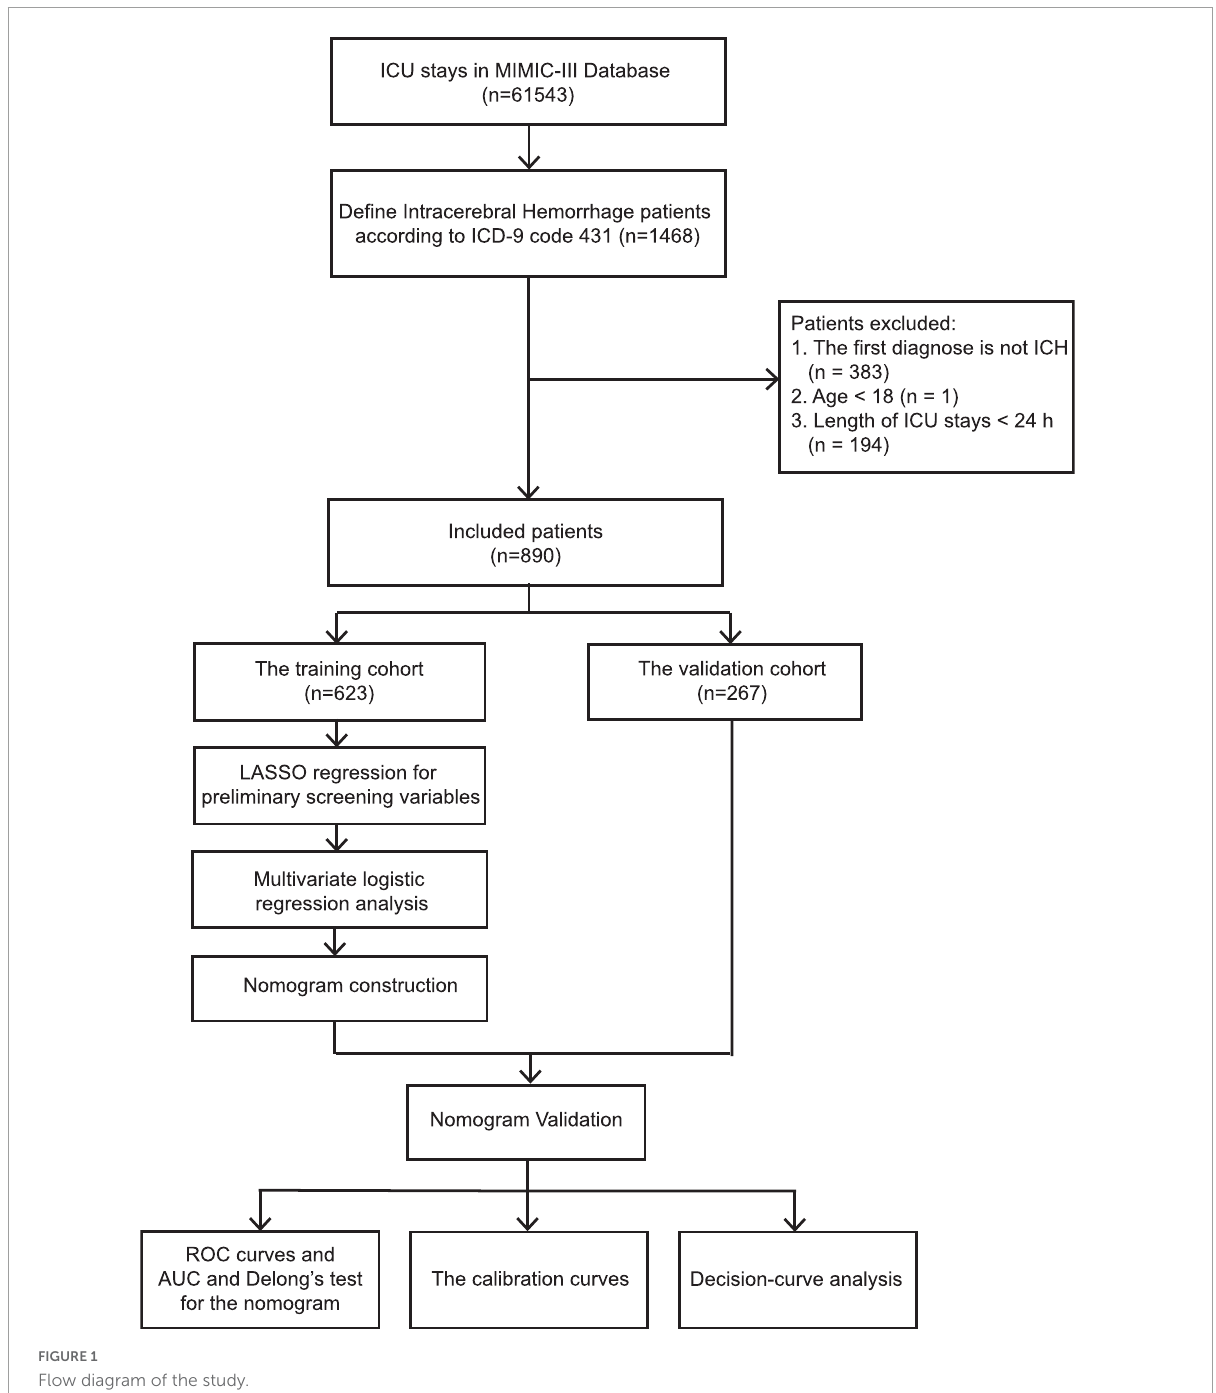
FIGURE1 Flow diagram of the study.